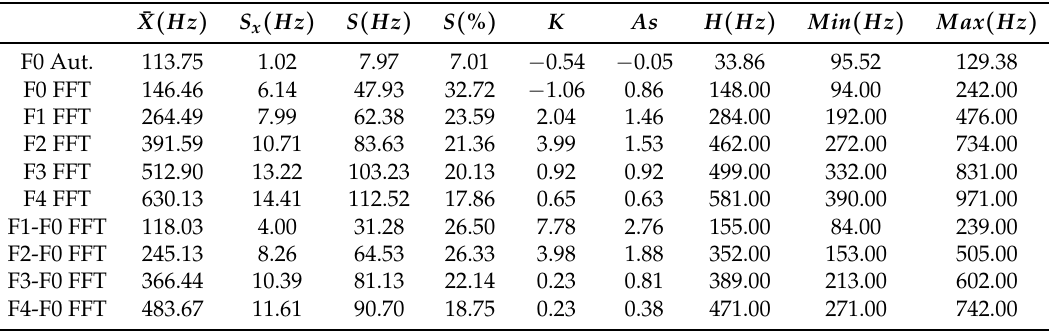
Table A1. Statistical descriptive measures of the frequency data of the standard group of A. fraterculus .